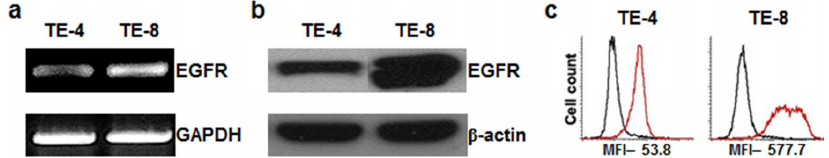
Figure 1. Analysis of epidermal growth factor receptor (EGFR) expression on esophageal squamous cell carcinoma (ESCC) TE-4 and TE-8 cell lines. ( a ) RT-PCR analysis. Internal control used human GAPDH . ( b ) Western blot. Internal control used human beta actin. ( c ) Flow cytometry analysis. Black line represents treatment with isotype control and red line represents treatment with cetuximab antibody.